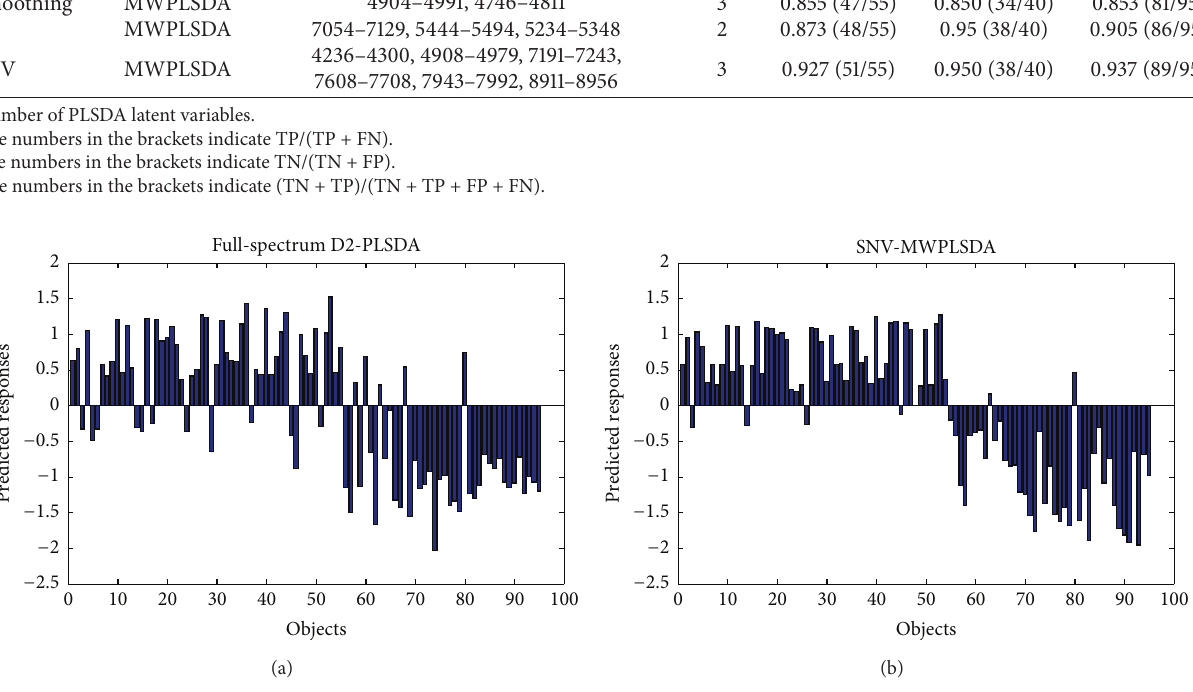
Figure 4: The prediction results of full-spectrum D2-PLSDA and SNV-MWPLSDA for 55 regular WLS (objects 1–55) and 40 dampened WLS (objects